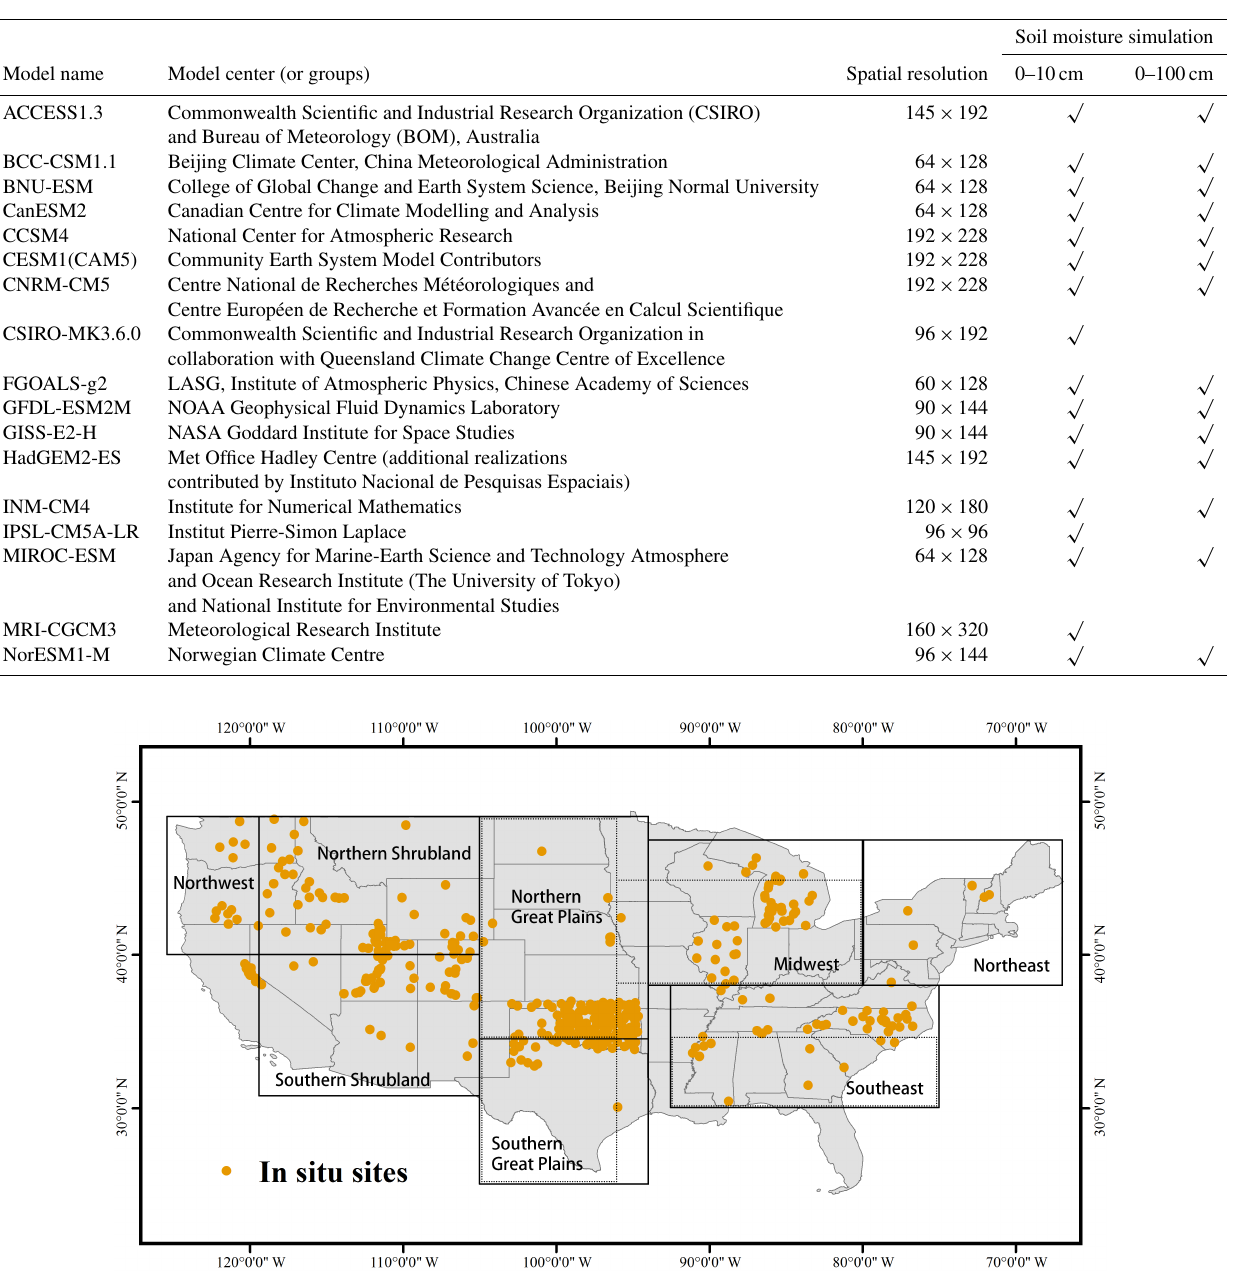
Figure 1. Spatial distribution of in situ soil moisture stations and the boundaries of the eight subregions.